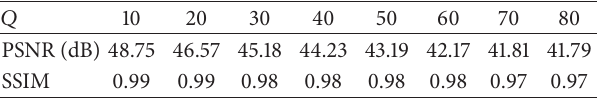
Table 1: Embedding strength versus PSNR and